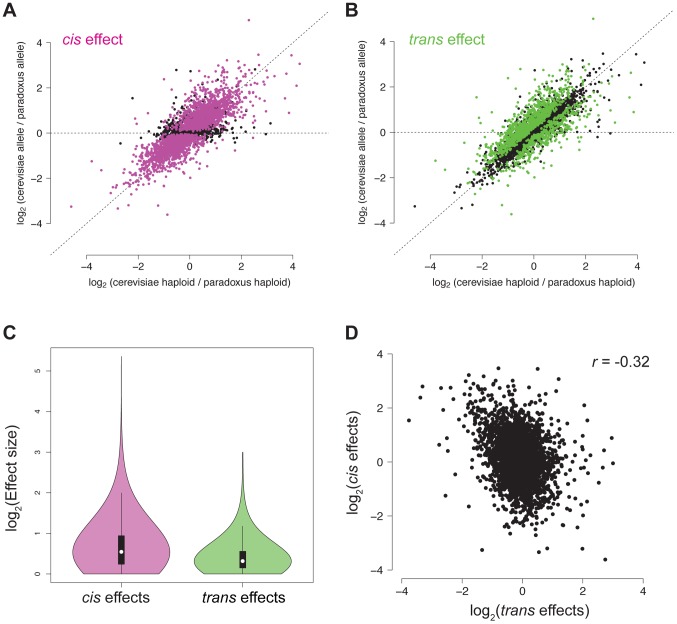

Cis and trans effects on chromatin accessibility.A. For each NFR, the relative chromatin accessibility in the haploid is plotted versus the relative chromatin accessibility in the diploid. NFRs with a significant cis effect are shown in pink. B. Reproduction of the plot from (A), but NFRs with a significant trans effect are shown in green. C. Violin plot showing the effect size distribution of cis and trans effects. D. Scatter plot of relative cis and trans effect sizes. Positive effects indicate higher accessibility in S. cerevisiae and negative effects indicate higher accessibility in S. paradoxus.